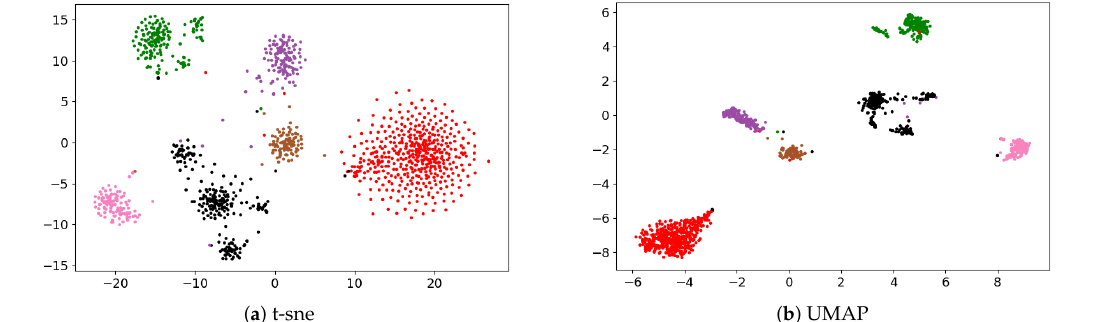
Figure 4. Visualization of cancer subtypes identified by spectral clustering from human melanoma scRNA-seq data set in two-dimensional space constructed by ( a ) t-SNE and ( b ) UMAP, respectively. Different colors denote different clusters output by spectral